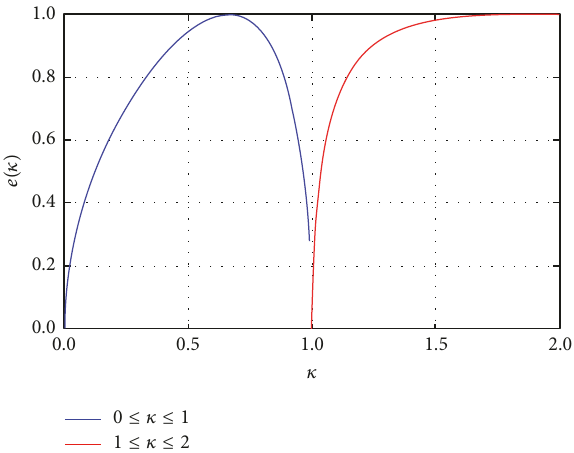
Figure 5: (Color online) eccentricity of the ellipse in elliptical polarization of the magnetic field as a function of 𝜅 , 0 ≤ 𝜅 ≤ 2